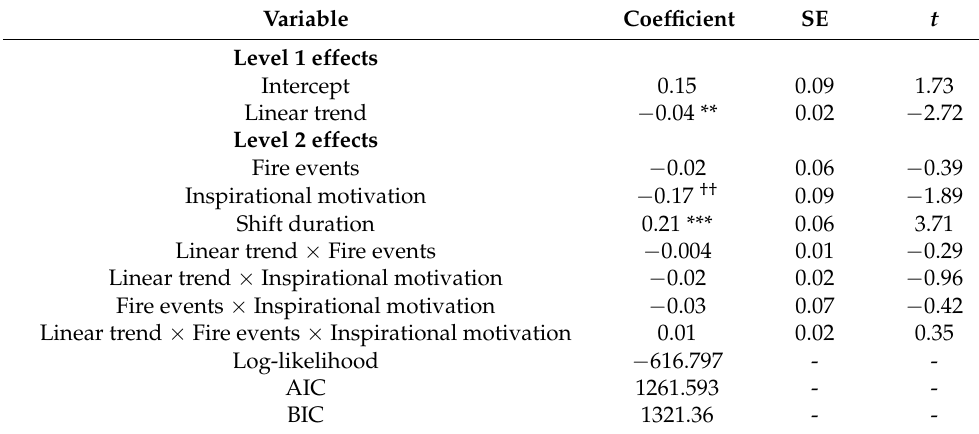
Table A8. Fire Events and Inspirational Motivation Predicting Change in Emotional Exhaustion.